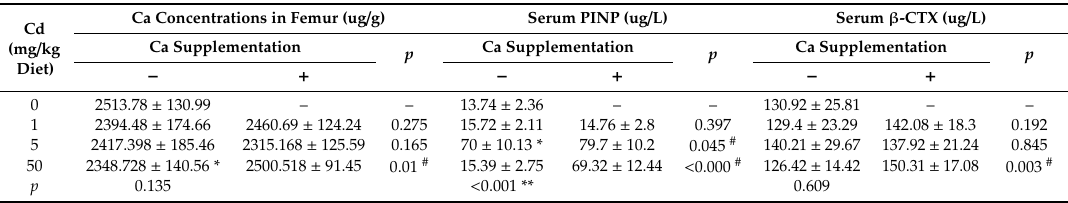
Table 9. Cd concentrations in femur and serum markers in the study of moderate Ca supplementation exposure to different diet Cd (Exp 2).